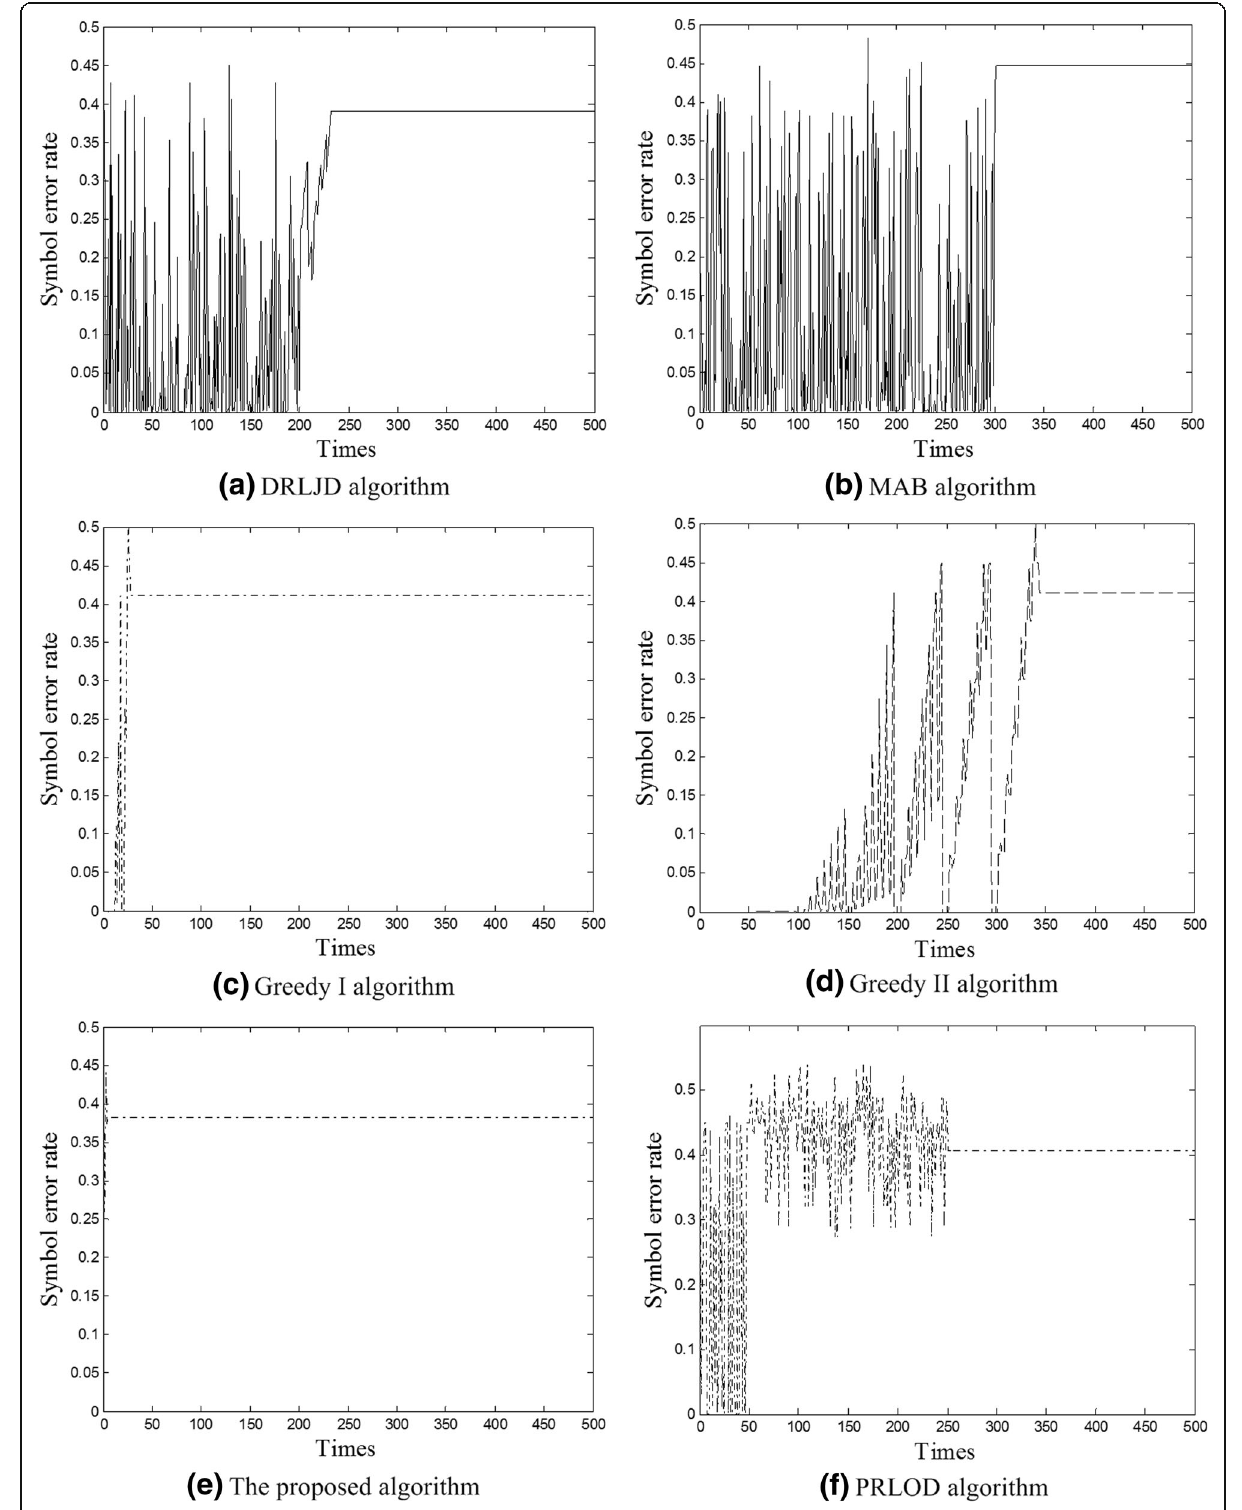
Fig. 8 Jamming performance among different algorithms. We address four additional algorithms to compare with the algorithm proposed in this paper, and the convergence curve shows the performance of the above five algorithms. a DRLJD algorithm. b MAB algorithm. c , d Greedy algorithm with different division manners. e Value prediction based on the algorithm proposed in this paper. f PRLOD